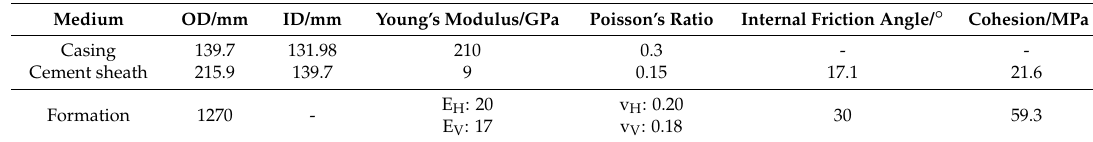
Table 1. Geometry parameters and material characteristics of the model.